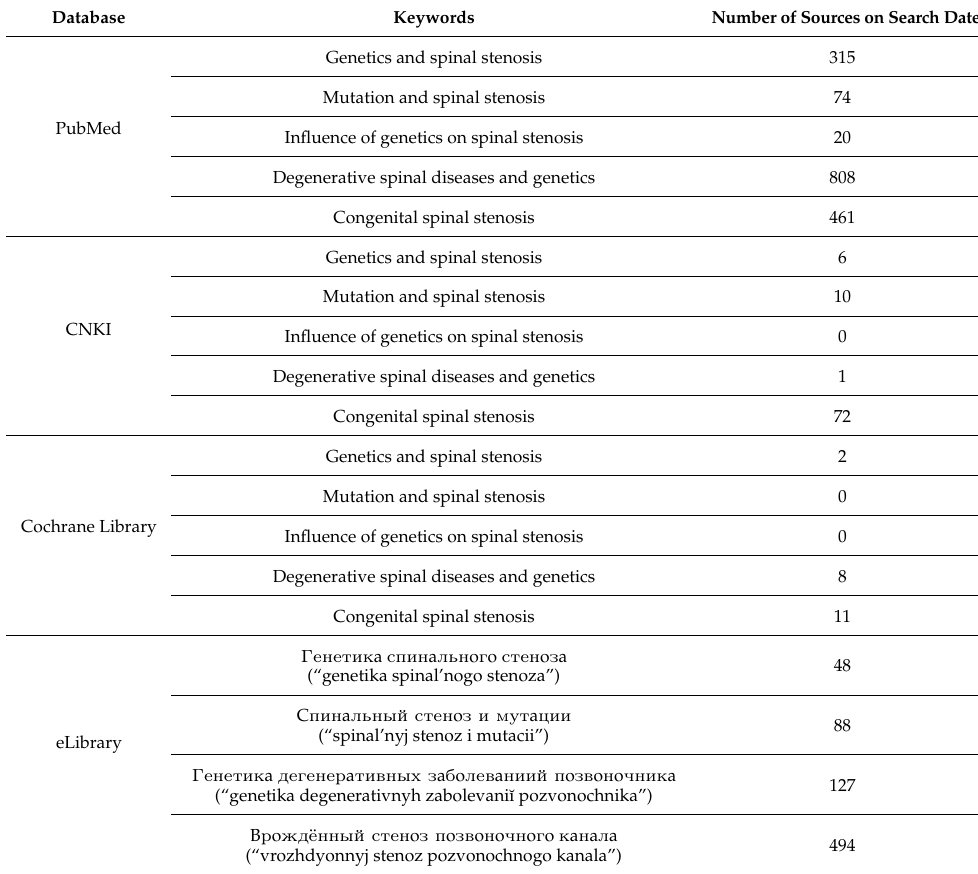
Table 1. Search results, by keywords, in electronic databases, performed on 10 June